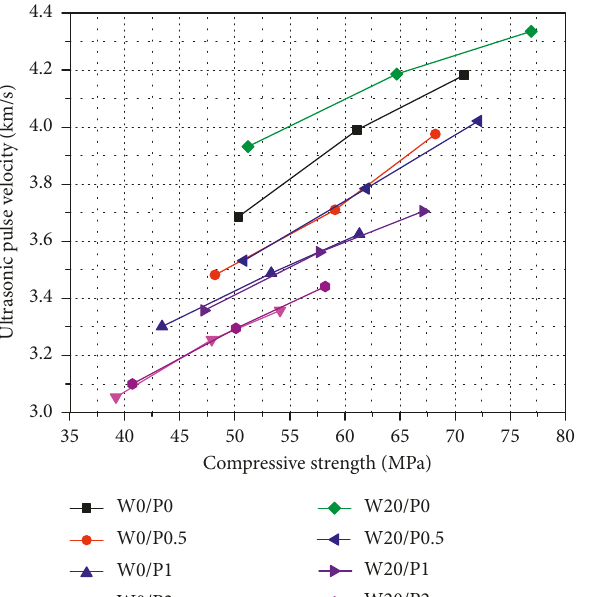
Figure 9: Ultrasonic pulse velocity-compressive strength relationship.